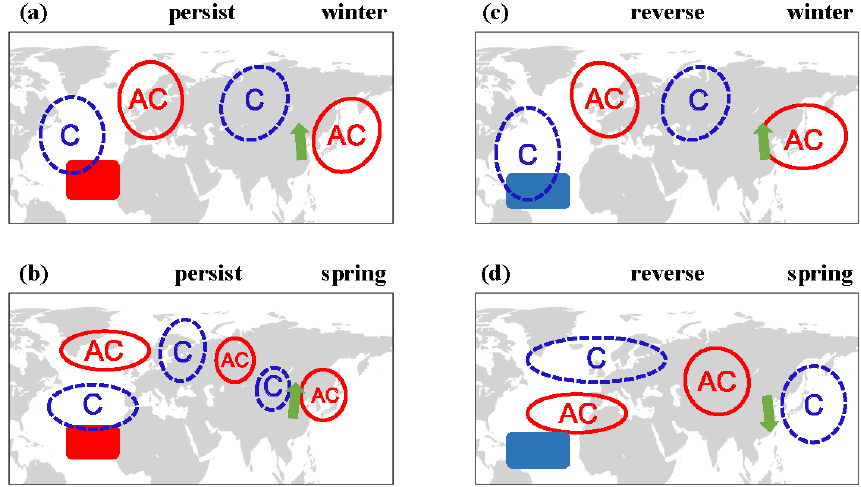
Figure 14. Schematic diagram showing evolutions of DECC, SST, and atmospheric circulation anomalies from winter to spring for (a, b) the persistent cases and (c, d) the reverse cases. Solid red contours (dashed blue contours) indicate anticyclonic circulation anomalies (cyclonic circulation anomalies). Red (blue) shading in the North Atlantic indicates positive (negative) SST anomalies.